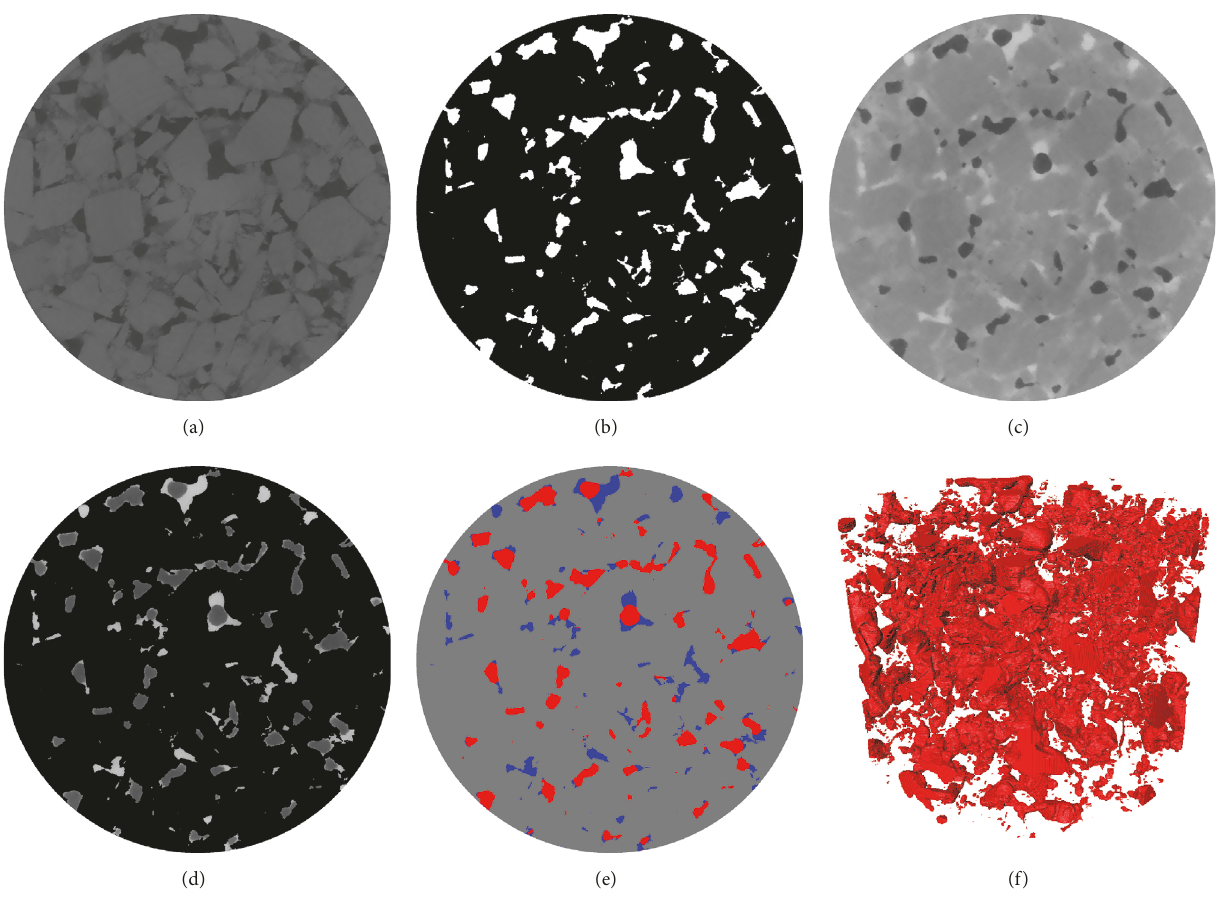
Figure 2: Horizontal cross-sectional slices through the plug (diameter = 1400 voxel) and the image processing workflow of wet and dry images taken during the water-wet plug flooding (slice number = 135, 24.92 mm from the inlet). (a) Filtered dry reference image; (b) pore map obtained from the filtered dry image, where the pore is transparent and the grain is black; (c) filtered wet image, where the darkest phase is oil, the light gray phase is brine, and the intermediate phase is solid particle; (d) combined wet image, where oil, brine, and the solid are dark gray, light gray, and black, respectively; (e) segmented wet image (brine: blue; oil: red; and grains: gray); (f) three-dimensional rendering of the oil phase. Brine and rock are transparent for effective visualization.